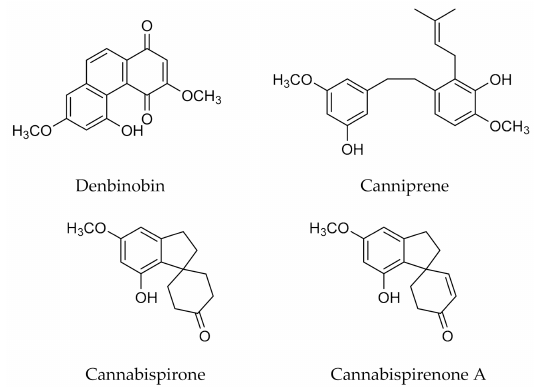
Figure 2. Examples of stilbenoids from Cannabis sativa L.